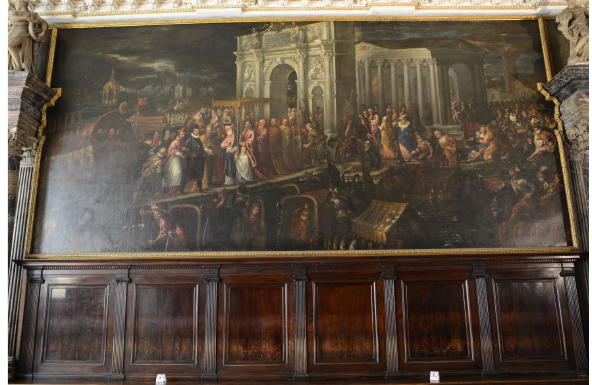
Figure 5. Andrea Vicentino, Enrico III re di Francia arriva a Venezia accolto dal doge Alvise Mocenigo e dal Patriarca, olio su tela, 7,81×3,67 m, 1595-1600, Venezia, Palazzo Ducale, Sala delle Quattro Porte.